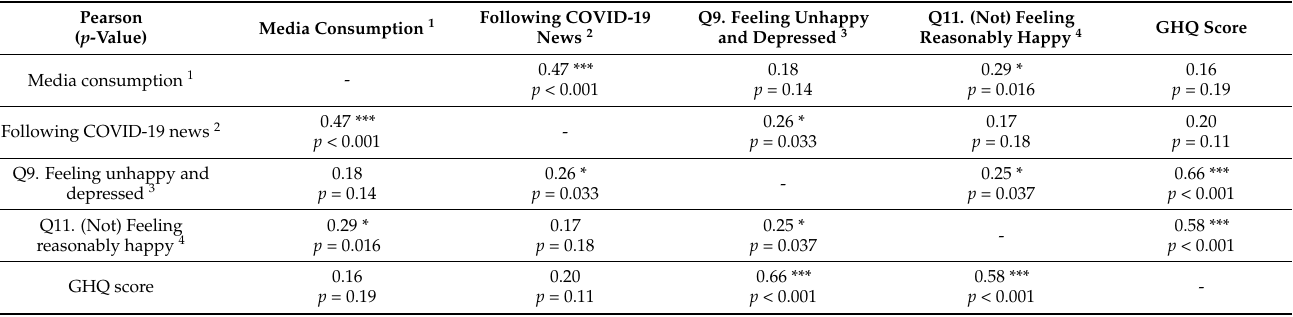
Table 2. Pearson correlational analyses between media consumption and